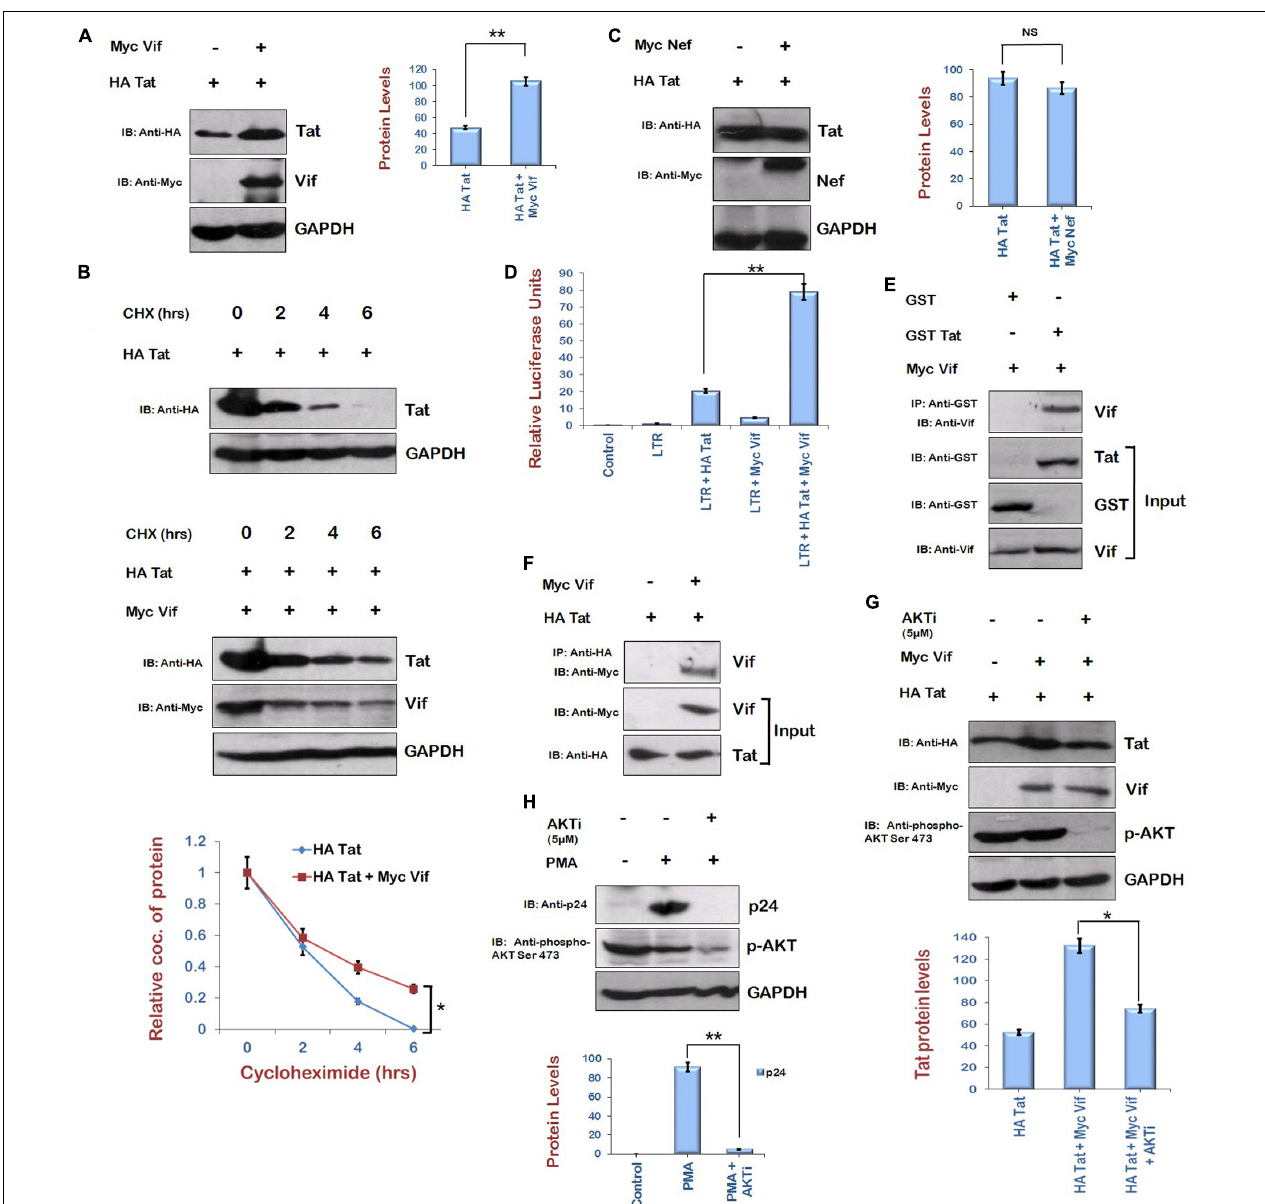
FIGURE 2 | Human immunodeficiency virus type 1 Vif increases the expression of Tat via AKT signaling pathway. (A) HEK-293T cells were cotransfected with HA Tat and Myc Vif plasmids as indicated for 24 h. Cell lysates were analyzed by Western blotting using anti-HA, anti-Myc, and anti-GAPDH antibodies. (B) HEK-293 T cells were transfected with HA Tat either alone or along with Myc Vif for 24 h. Cells were treated with cycloheximide (100 µ g/mL) for the indicated time periods. Cell lysates were subjected to Western blot analysis using anti-HA, anti-Myc, and anti-GAPDH antibodies. Densitometric analysis was done by ImageJ and shown as line graph with error bars. (C) HEK-293T cells were cotransfected with HA Tat and Myc Nef plasmids as indicated for 24 h. Cell lysates were analyzed by Western blotting using anti-HA, anti-Myc, and anti-GAPDH antibodies. (D) HEK-293T cells were cotransfected with HIV-1 LTR-luc reporter, Renilla luciferase, HA Tat, and Myc Vif expression plasmids as indicated for 24 h. Cells were lysed, and dual luciferase reporter assay was performed using luminometer. Relative luciferase activity is shown as bar graph. (E) GST Tat and GST alone bound with GST beads were incubated with in vitro synthesized Vif for 2 h at 4 ◦ C. Vif specific antiserum was used to probe the Vif protein in Western blot analysis. GST alone was used as negative control. (F) Tzm-Bl cells were transfected with HA Tat and Myc Vif plasmids for 24 h. Cell lysates were subjected to immunoprecipitation using anti-HA agarose beads at 4 ◦ C overnight. After incubation, beads were washed with IP buffer and boiled with PAGE loading buffer followed by SDS-PAGE and Western blotting using anti-Myc antibody. (G) HEK-293T cells were cotransfected with HA Tat and Myc Vif plasmids as indicated and treated with AKTi (5 µ M) for 24 h. Cell lysates were analyzed by Western blotting using anti-HA, anti-Myc, anti–phospho-AKT Ser473, and anti-GAPDH antibodies. (H) HIV-1 replication in U1 cells was induced by PMA (100 µ g/mL), and cells were treated with AKTi (5 µ M) for 24 h. Cell lysates were analyzed by Western blotting using anti-p24, anti–phospho-AKT Ser473, and anti-GAPDH antibodies. GAPDH was used as loading control. Densitometry analysis was performed using ImageJ and shown as bar graph with error bars. Data obtained are presented as mean ± s.e.m. of three independent experiments. p -value was calculated by two-tailed t -test [* p < 0.05, ** p < 0.01, NS (not significant)].